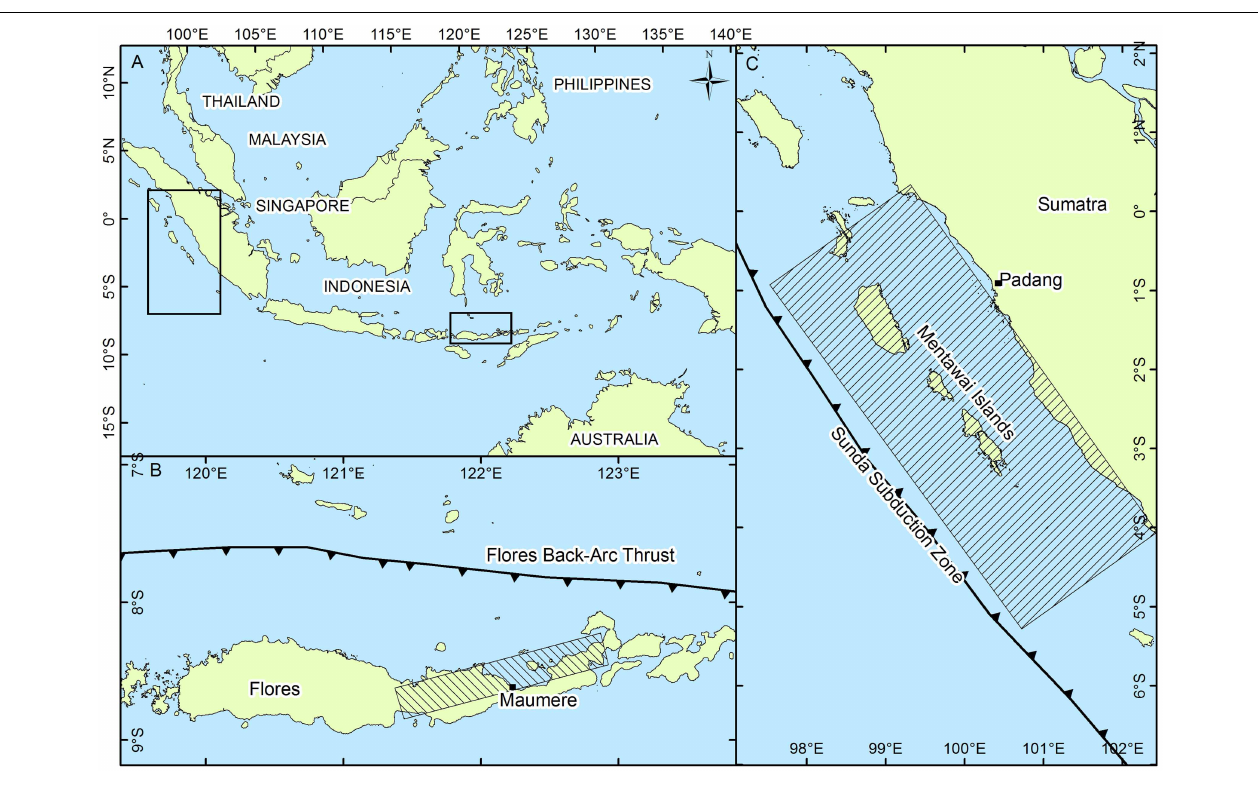
for Maumere does not align with where the Flores Back-Arc Thrust is typically mapped. Fault traces are those used in the 2010 revision of Indonesia’s national seismic hazard map ( Irsyam et al.,